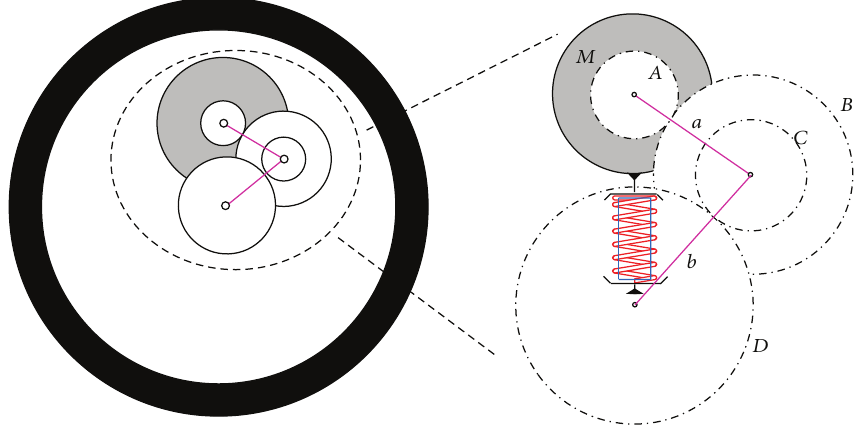
Figure 3: E-DVA system concept based on slider-crank mechanism.